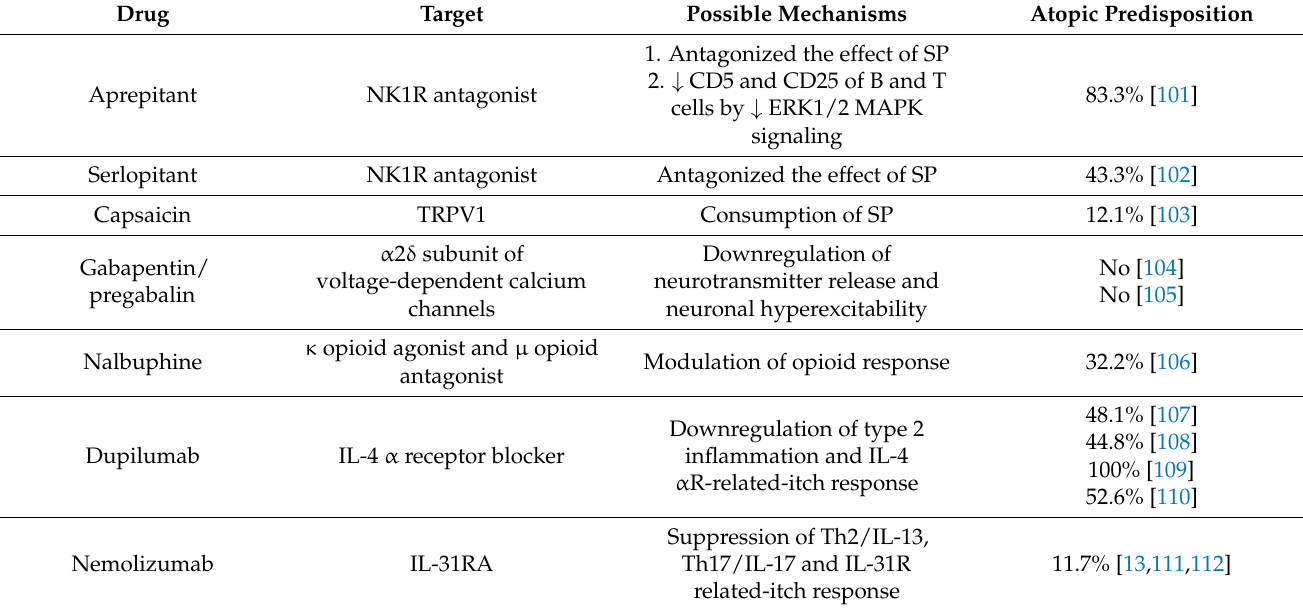
Table 1. Potential targeted treatments in